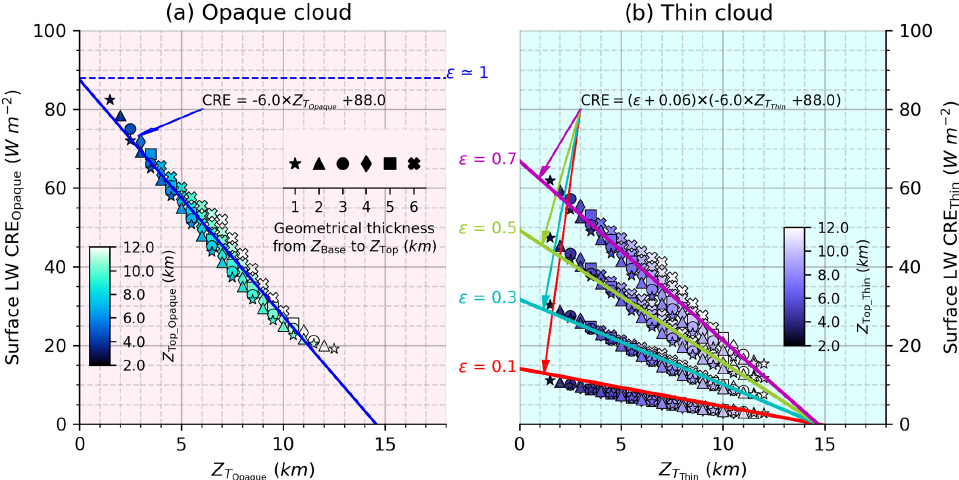
Figure 3. Linear relationships derived from 1D radiative transfer computations between the surface LW CRE and the cloud altitude for a single overcast column containing (a) an opaque cloud above a thin cloud, both moving in altitude, and (b) a thin cloud of emissivity 0.1 (red), 0.3 (cyan), 0.5 (green) and 0.7 (pink). These linear relationships (solid lines) are derived from direct radiative transfer computations (dots). Each dot represents the result of one radiative transfer computation. The color of dots represents the cloud top altitude (2km, dark, to 13km, bright) and the shape of dots the geometrical thickness from the cloud base to cloud top (1km, a star, to 6km and above, a cross). The atmospheric state is taken from ERA-Interim reanalysis for January at a latitude of 39 ◦ N over the ocean. As an example, in plot (a) the slope is − 6 . 0Wm − 2 km − 1 , and the intercept is 88.0Wm − 2